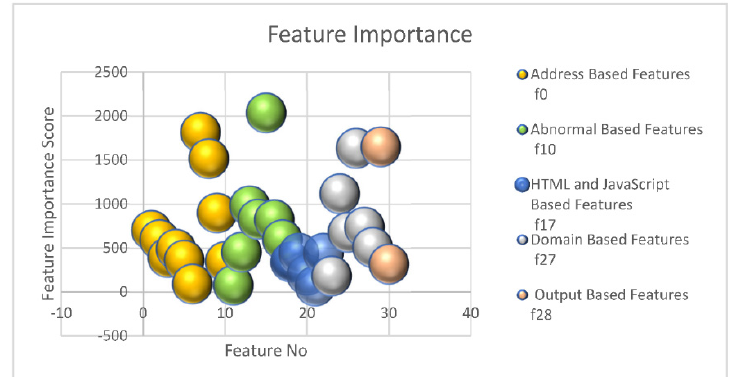
Figure 5. Feature importance distribution of URL extracted by APBA.